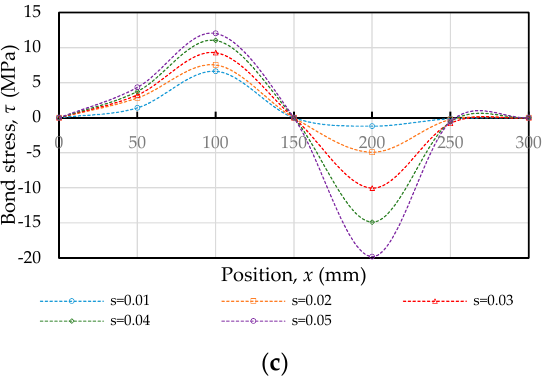
Figure 13. Bond stress vs. slip relationship along embedded length with the same slip value: ( a ) C20, ( b ) C40, and ( c ) C60.